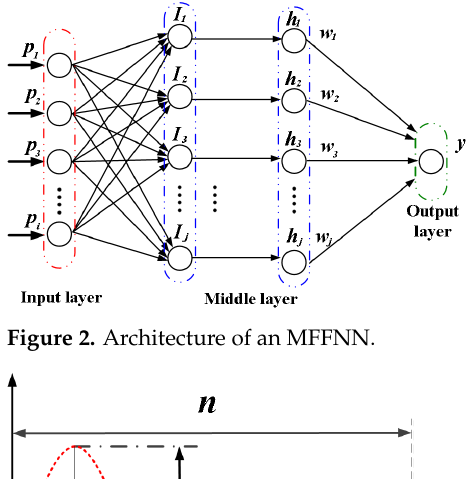
Figure 2. Architecture of an MFFNN.